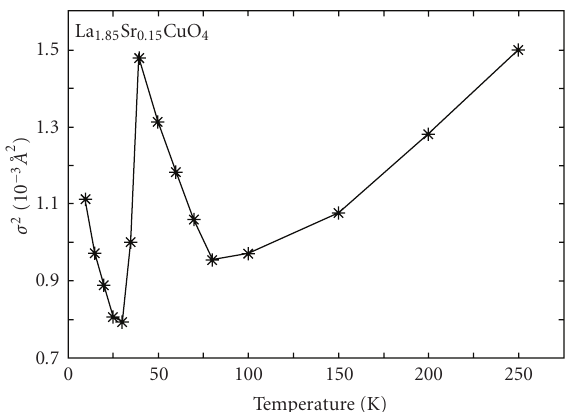
Figure 11: The mean square in-plane Cu-O bond distance of La 1 . 85 Sr 0 . 15 CuO 4 as a function of temperature. After [26–28].